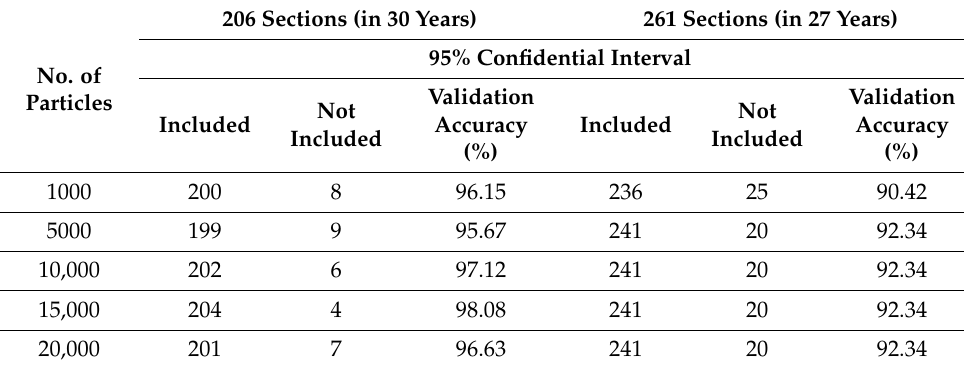
Table 3. Comparison and verification of prediction accuracy for each section according to the change in the number of